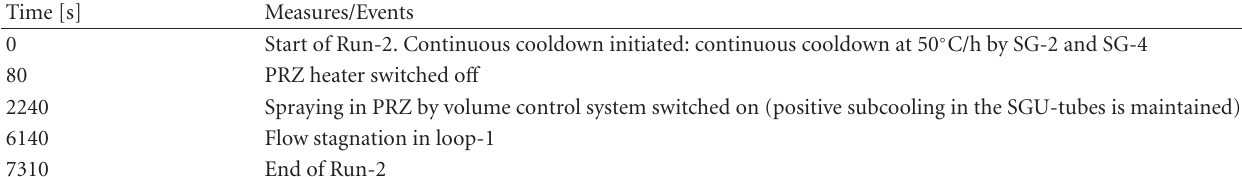
Table 4: Main events for PKL2 G2.1 Run-2.